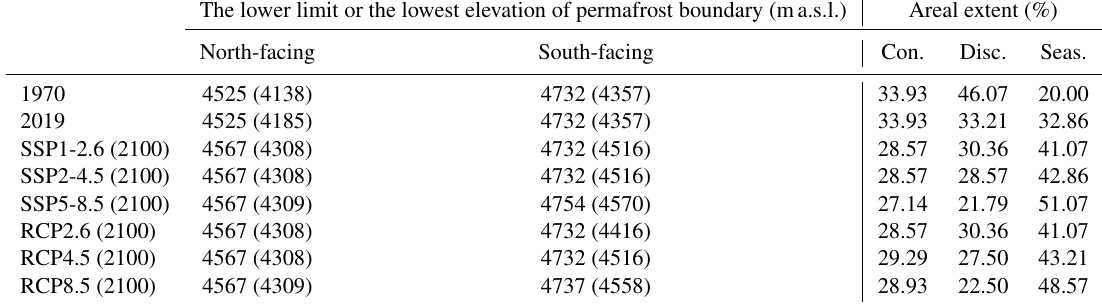
Table 2. Variations in the permafrost boundary and areal extent of the frozen ground type over Xidatan for 1970–2019 and projected variations by 2100 under different climate change scenarios. The lower limit or the lowest elevation of permafrost boundary (ma.s.l.)